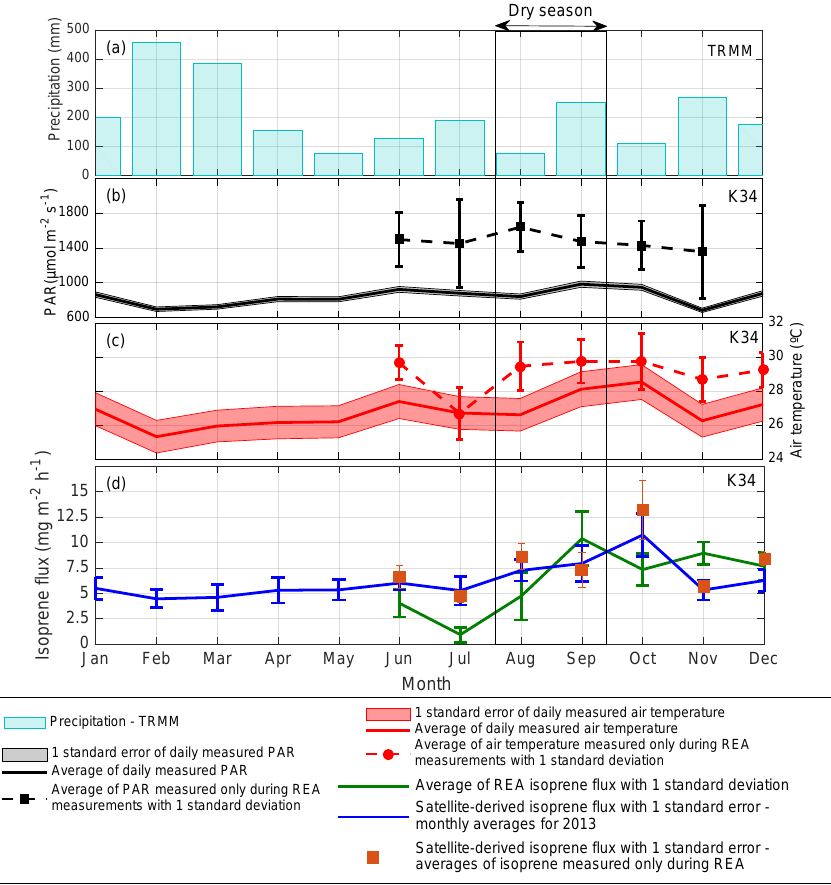
Figure 3. (a) Monthly cumulative precipitation given by the Tropical Rainfall Measuring Mission (TRMM) for the K34 tower domain in 2013. (b) Monthly averages of PAR and (c) air temperature, both measured every 30min during 06:00–18:00 local time at the K34 tower site in 2013. (d) Isoprene flux measured with the REA system at the K34 tower site in 2013 and OMI satellite-derived isoprene flux for the K34 tower